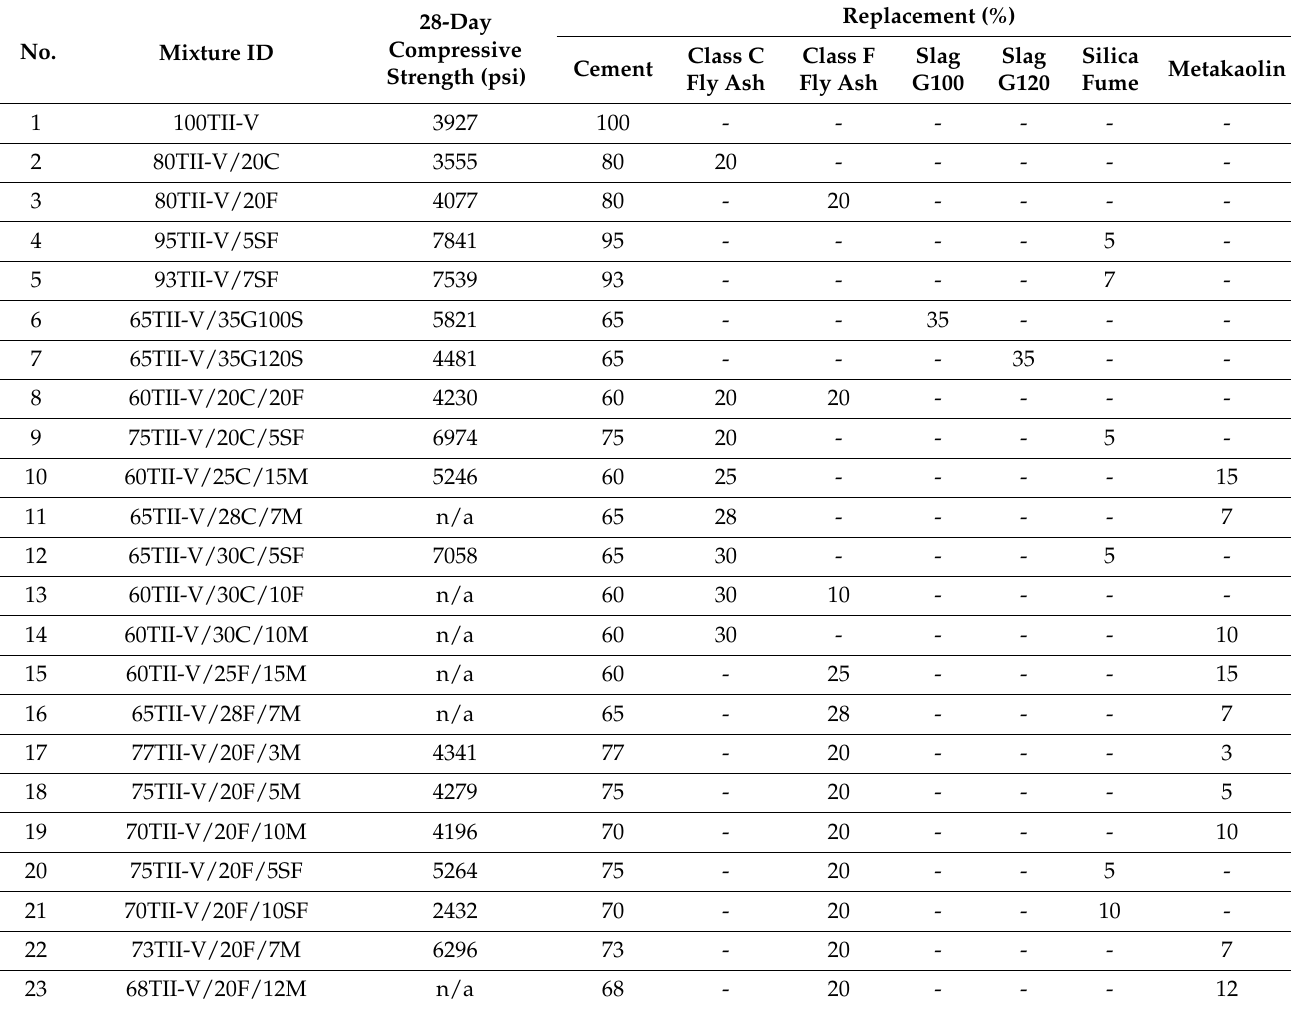
Table 1. Concrete mixture constituents and